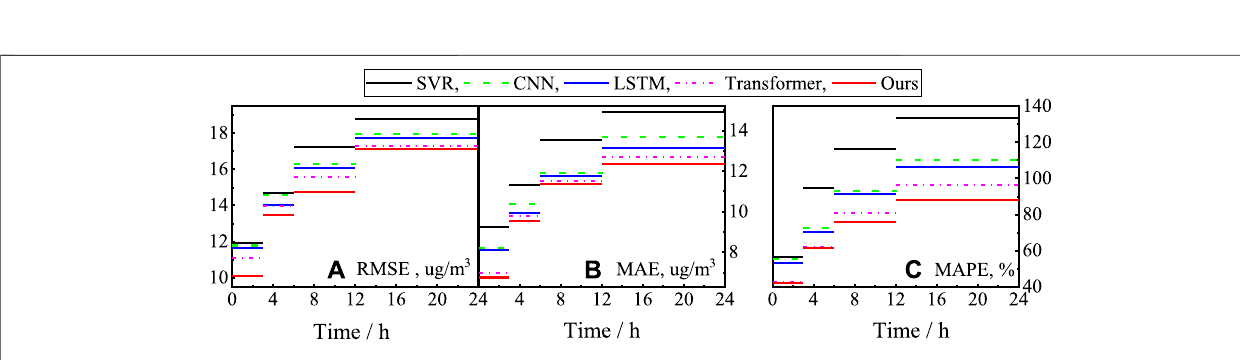
FIGURE 11 | Comparisons of different methods for multi-step prediction results for the next 24 h on Taizhou dataset.